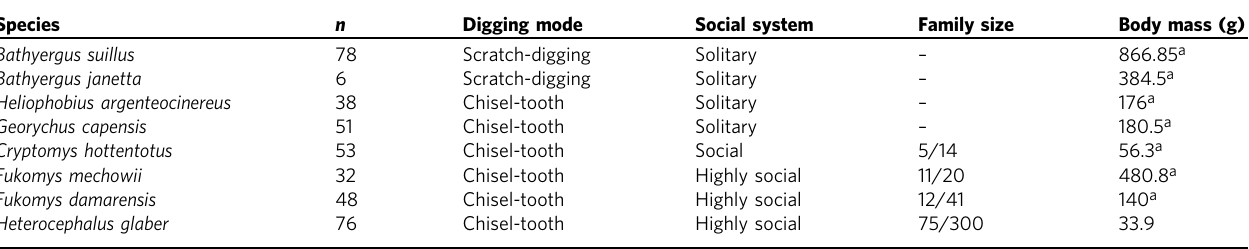
Table 1 Digging mode, social system, family size (mean/max.), body mass (mean), and sample size ( n ) of African mole-rats (Bathyergidae) analyzed in this study.